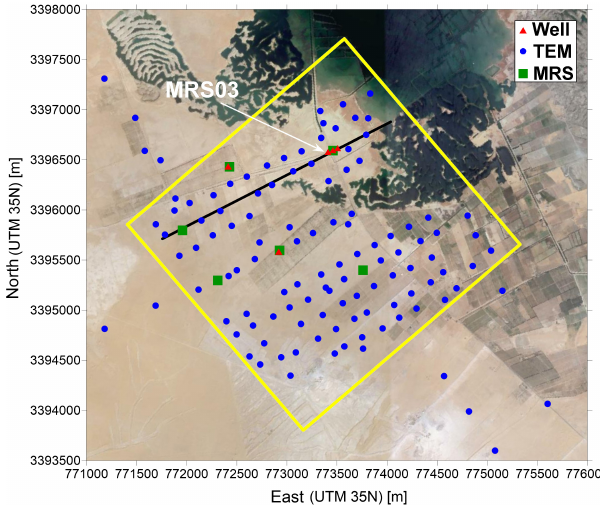
Figure 5. The location map of the boreholes (red triangles) and the TEM (blue dots) and MRS (green squares) measurements carried out in the surrounding area of the Nubariya pond. The black line represents the trace of the cross section through the resistivity model shown in Fig. 6. The location of MRS03 is highlighted. The domain of the local-scale model is shown by the yellow box. The back- ground is a Landsat image acquired in 2014 available from the US Geological Survey.